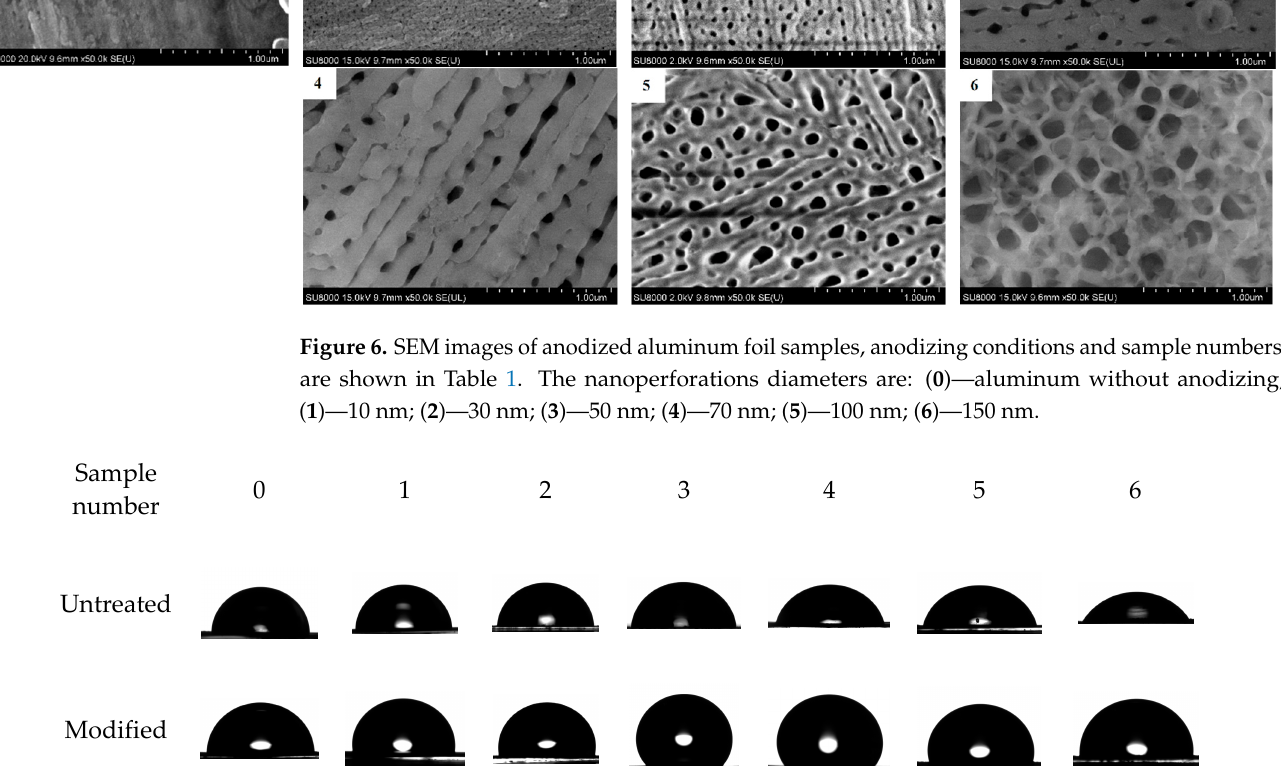
Figure 6. SEM images of anodized aluminum foil samples, anodizing conditions and sample num- bers are shown in Table 1. The nanoperforations diameters are: ( 0 )–aluminum without anodizing; ( 1 )–10 nm; ( 2 )–30 nm; ( 3 )–50 nm; ( 4 )–70 nm; ( 5 )–100 nm; ( 6 )–150 nm.